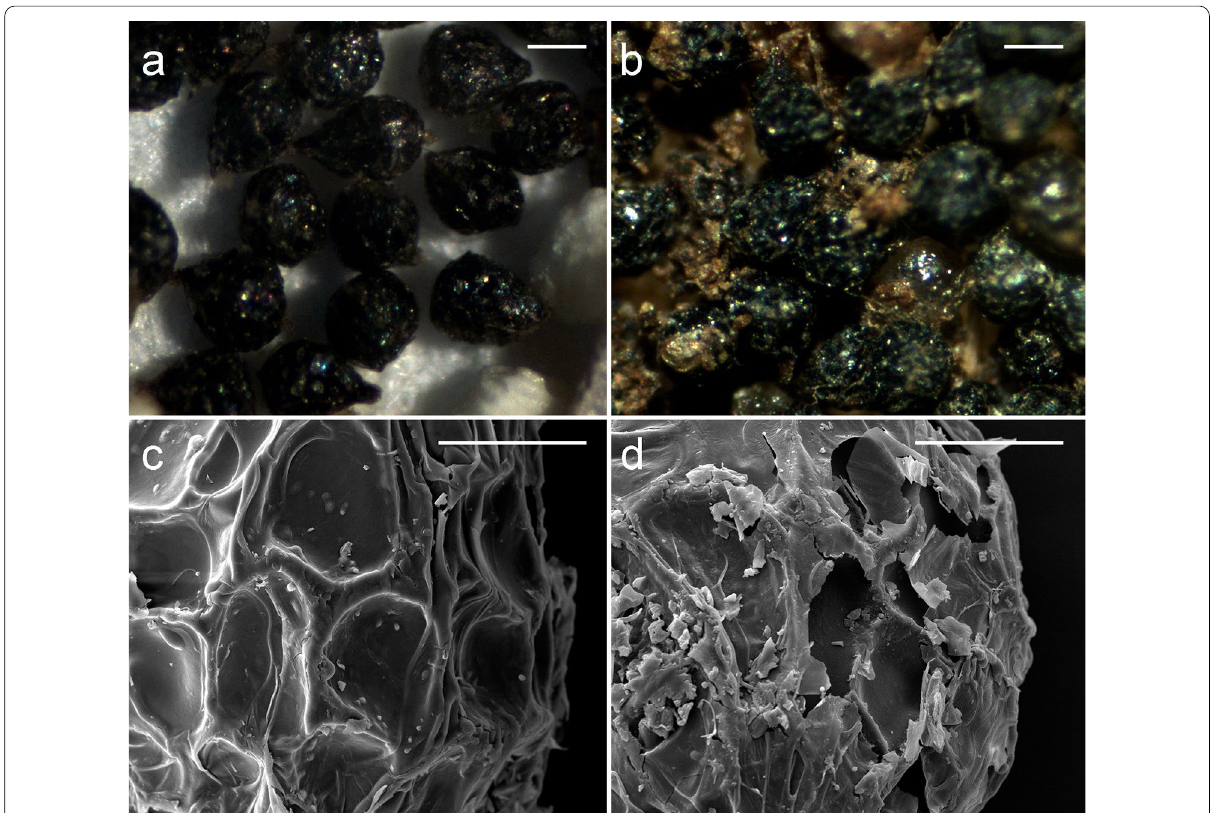
Fig. 3 Mature seeds and seeds defecated from birds of N. singapureana . a Mature seeds. Bar c SEM micrograph showing the surface of mature seed. Bar Bar 50 µm =